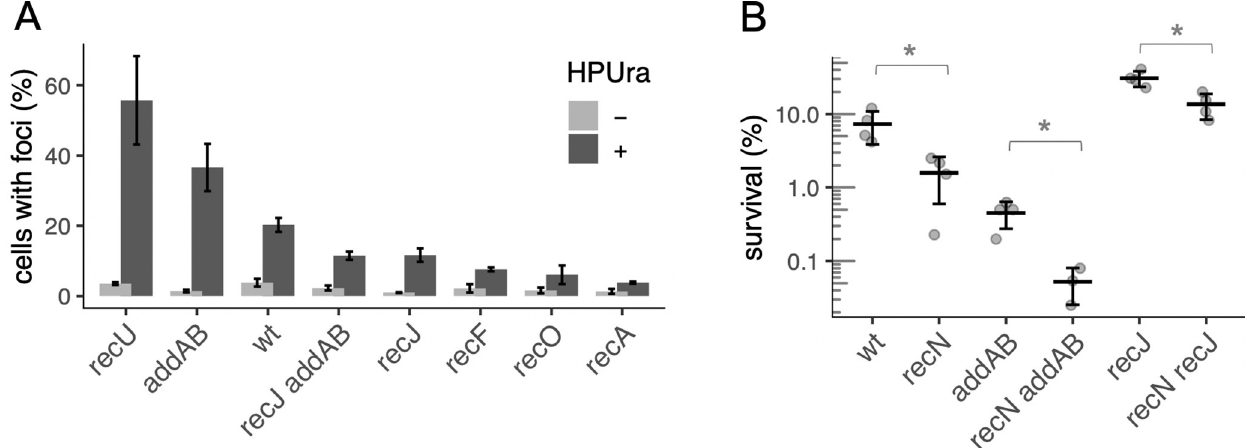
Fig 5. Accumulation of exposed DNA ends during replication arrest by HPUra. A. Repair centers in response to exposed DNA ends were visualized by fluorescence microscopy of cells expressing the RecN-mNeongreen fusion. Cell membranes were stained with FM 4–64 and DNA was stained with DAPI. Wild-type (LSF708), Δ recU (LSF740), Δ addA (LSF650), Δ recO (LSF818), Δ recJ (LSF649), Δ recF (LSF816), Δ recJ Δ addA (LSF706), and Δ recA (LSF756) cells were analyzed without (gray) or 30 min after treatment with HPUra (black). At least 800 cells from two biological replicates were analyzed from each strain for the presence of RecN-mNeongreen foci. The means and standard errors are presented. B. Loss of recN causes a phenotype in cells with or without addAB or recJ . Percent survival of wild type (LSF225), Δ recN (LSF536), Δ addAB (LSF254), Δ recN Δ addA (LSF652), Δ recJ (LSF231), and Δ recN Δ recJ (LSF651) are plotted. � Statistically different means according to two-tailed t-test: � P <